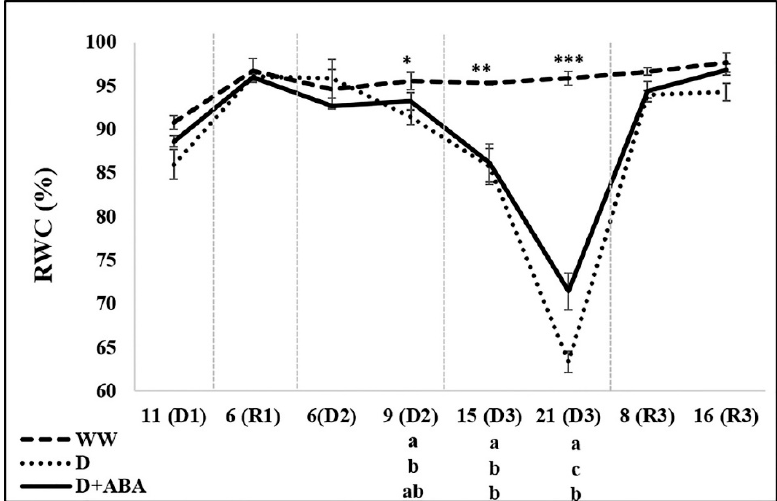
Figure 3. Changes of relative water content (RWC), of days of drought (D1, D2, D3) and recovery (R1, R3) in each cycle, in leaves of well-watered (WW) and droughted without (D) and with abscisic acid (D + ABA) plants. Each point is average and vertical bars represent the S.E. ( n = 8). Different letters indicate significant differences among treatments within each date (* p < 0.05, ** p < 0.01, *** p < 0.001). Nine days after starting the 2nd DP, in opposite to the lower RWC values of D plants, D + ABA plants were able to keep similar RWC as WW plants. Moreover, fifteen days after starting the 3rd DP both D and D + ABA treatments showed lower RWC than WW plants, while after 21 days D + ABA plants presented a lower decrease of RWC than D plants.